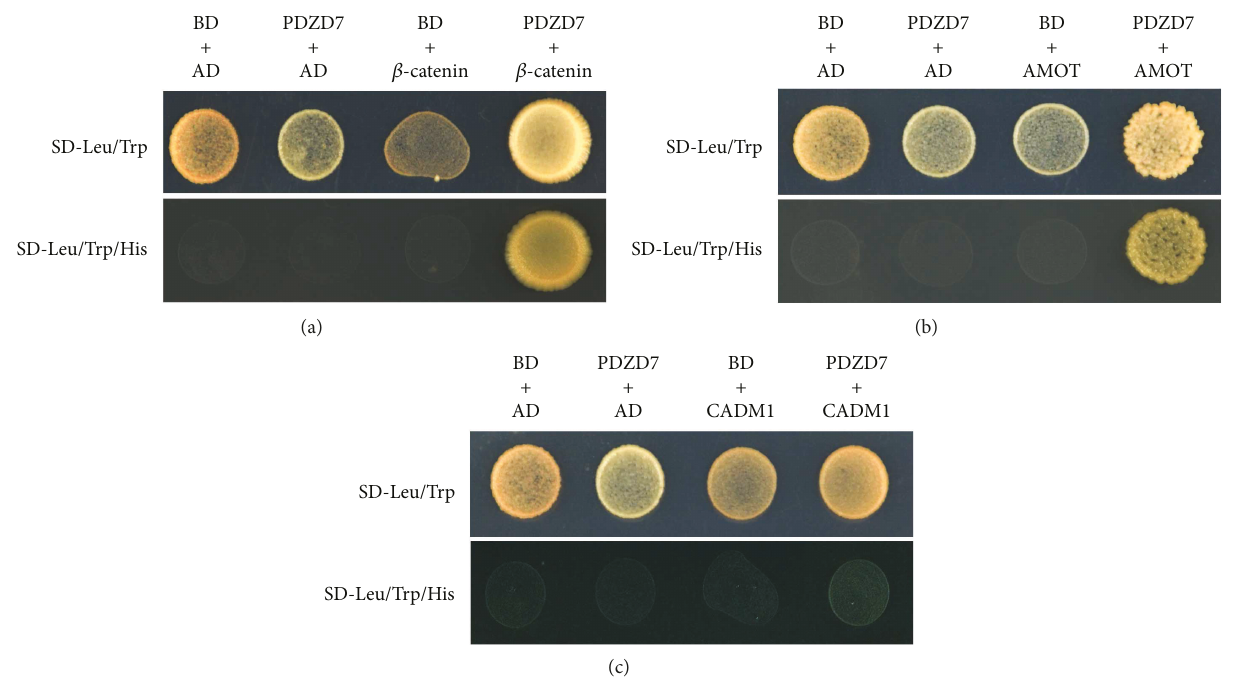
Figure 1: Veri fi cation of protein interactions by performing yeast two-hybrid experiments. AH109 yeast cells containing either Gal4 BD/Gal4 AD, Gal4 BD-PDZD7/Gal4AD, Gal4BD/Gal4 AD- β -catenin, Gal4 BD/Gal4AD-AMOT, Gal4BD/Gal4 AD-CADM1,Gal4 BD-PDZD7/Gal4 AD- β -catenin, Gal4 BD-PDZD7/Gal4 AD-AMOT, or Gal4 BD-PDZD7/Gal4 AD-CADM1 were plated on nonselective ( − Leu/Trp) and selective ( − Leu/Trp/His) plates with the presence of 2.5mM 3-AT and incubated at 30 ° C for 3